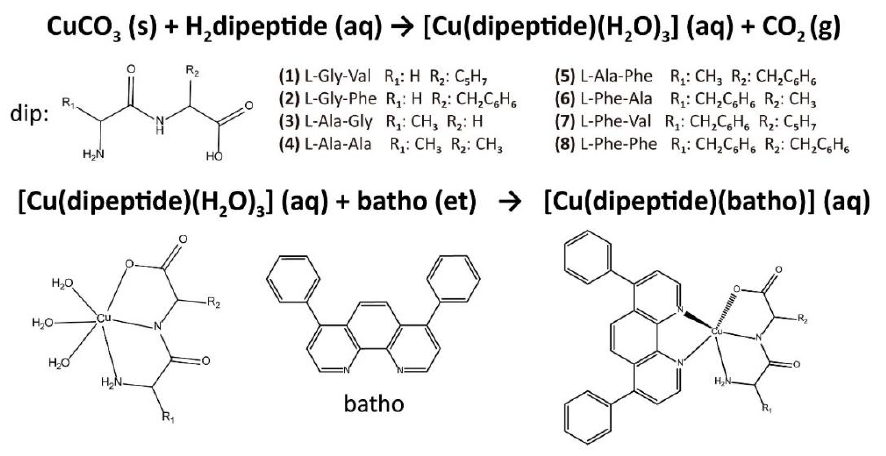
Figure 1. Scheme of the proposed structure of complexes and synthetic scheme.